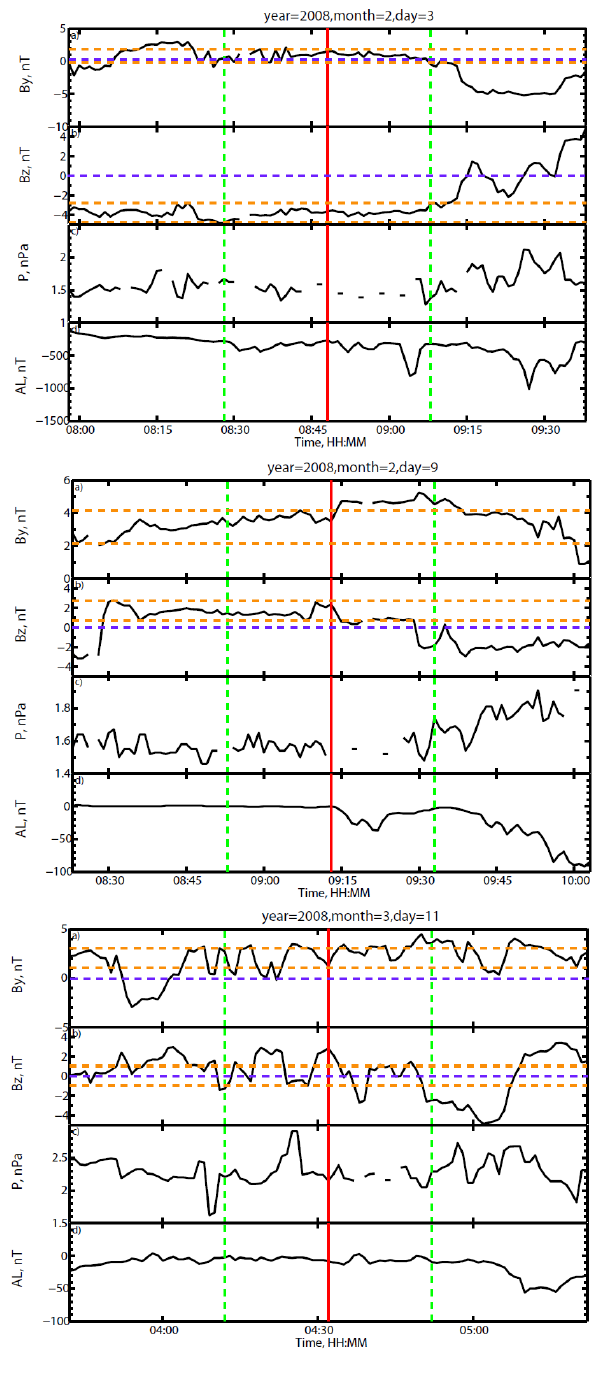
Fig. 3. Examples of Non-triggered events in the same format as Fig. 1.